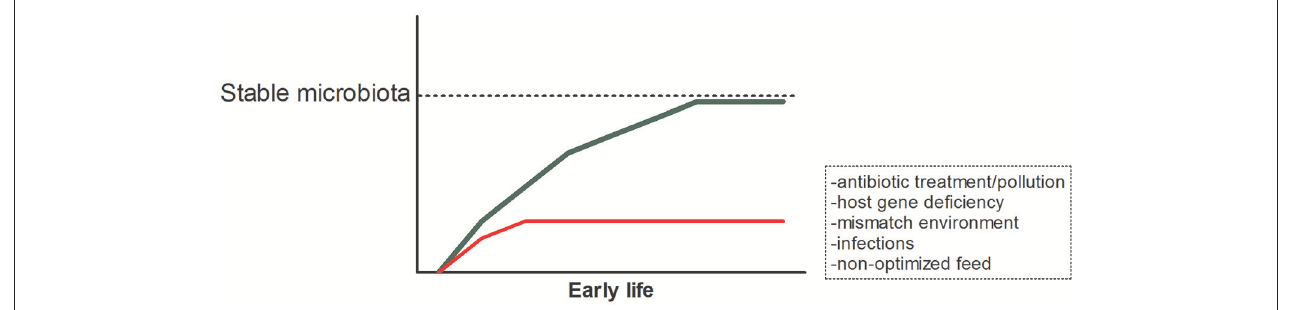
FIGURE 1 | Early life establishment of the microbiota and possible